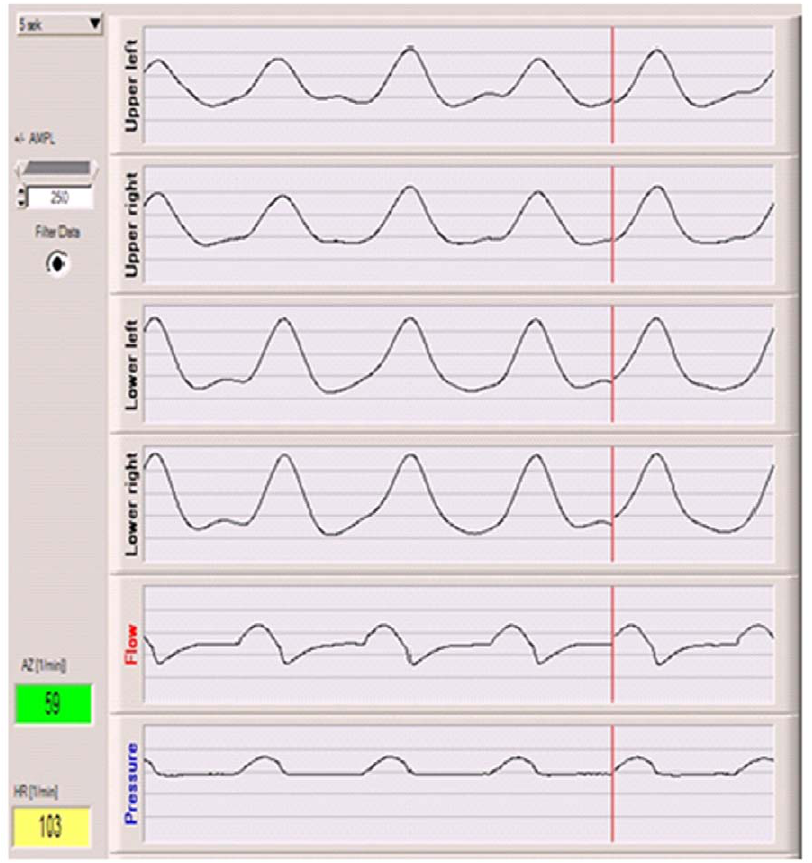
Figure 3. Tracing signal of impedance measurement during 5 breathing cycles. Shown are tracing signals of QIM measurements from 4 quadrants during 5 respiratory cycles. In addition flow and pressure curves from the ventilator are shown below in order to illustrate the time course of impedance changes with respect to ventilatory cycles from the ventilator.